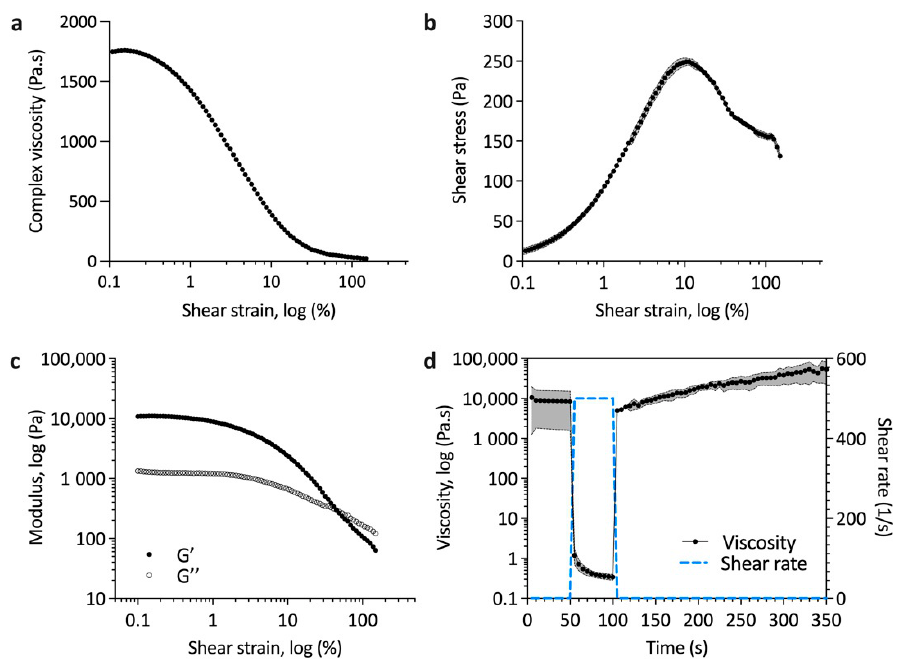
Figure 3. Rheological characterisation of Hap–collagen–alginate ink showing ( a ) yield behaviour with increasing shear strain where complex viscosity was calculated from the storage and loss data, ( b ) yield point and initiation of flow with increasing shear strain, ( c ) storage and loss moduli with respect to increasing shear strain and ( d ) thixotropic recovery after high-rate shearing. Data are plotted as mean ± SD (shaded region), n = 3.